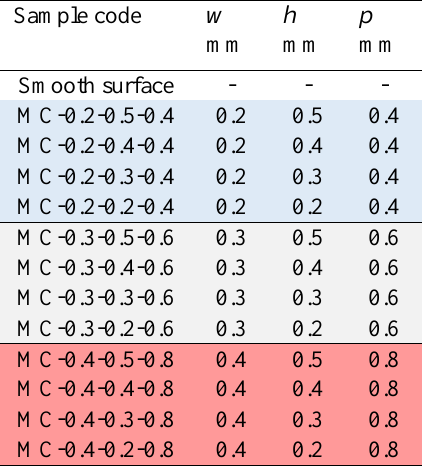
Fig. 1. Pool boiling measurement stand: 1 – main module, 2 – wattmeter, 3 – autotransformer, 4 – data logger, 5 – dry-well calibrator, 6 – high speed camera, 7 – light, 8 – PC. Table 1. MC surface codes and specifications.